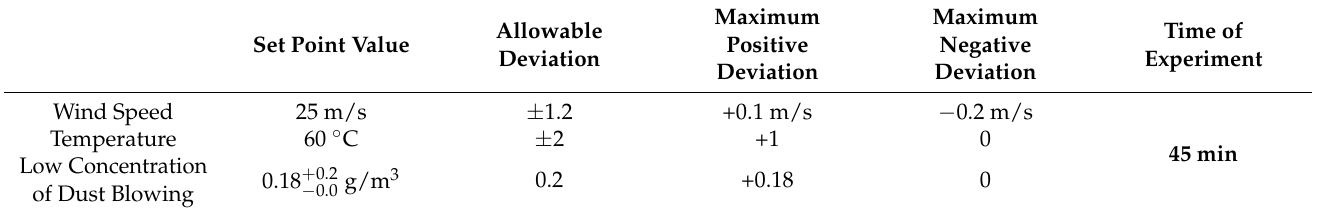
Table 6. Commissioning Results of 25 m/s Wind Speed, High Temperature and Low